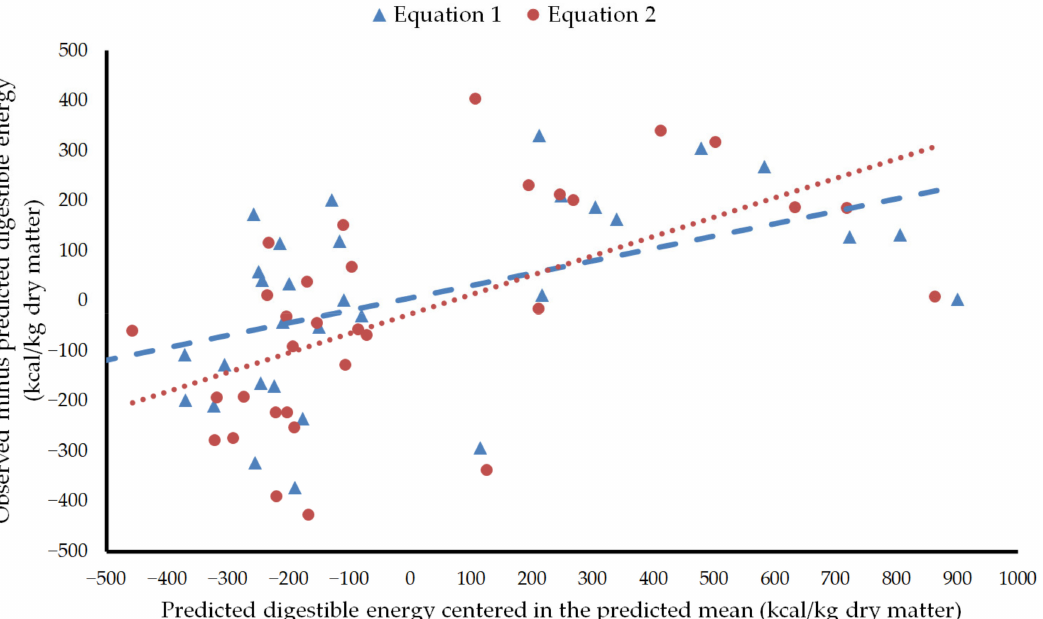
Figure 2. Plot of residuals versus predicted digestible energy centered in the predicted mean. Equa- tion 1: Equation of N ú ñez-S á nchez et al. [8]. Equation 2: Equation of Zeyner and Kienzle [14] modified as presented in Kienzle and Zeyner